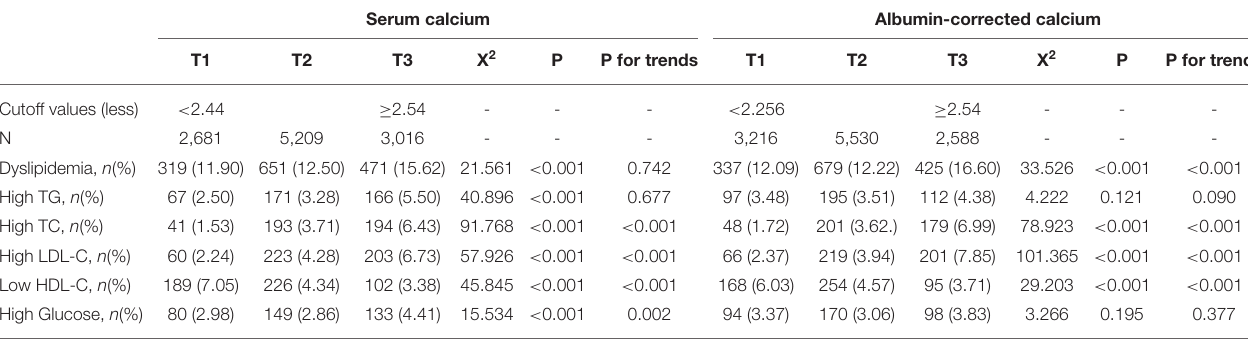
TABLE 3 | The rate of dyslipidemia and components trends with serum calcium and albumin corrected calcium. Serum calcium